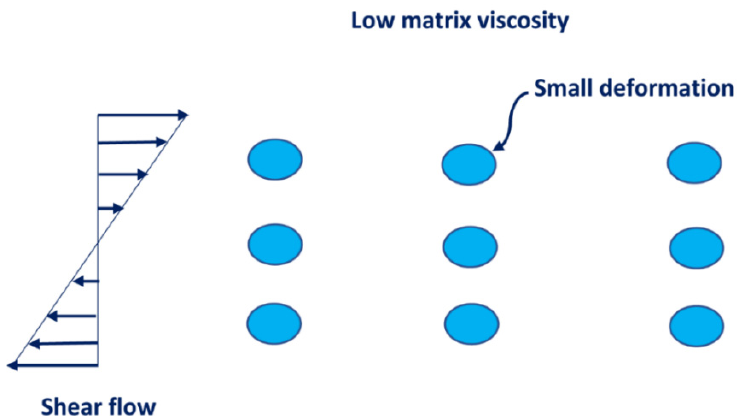
Figure 14. Small deformation of droplets at low concentration of nanoparticles at any given shear rate.